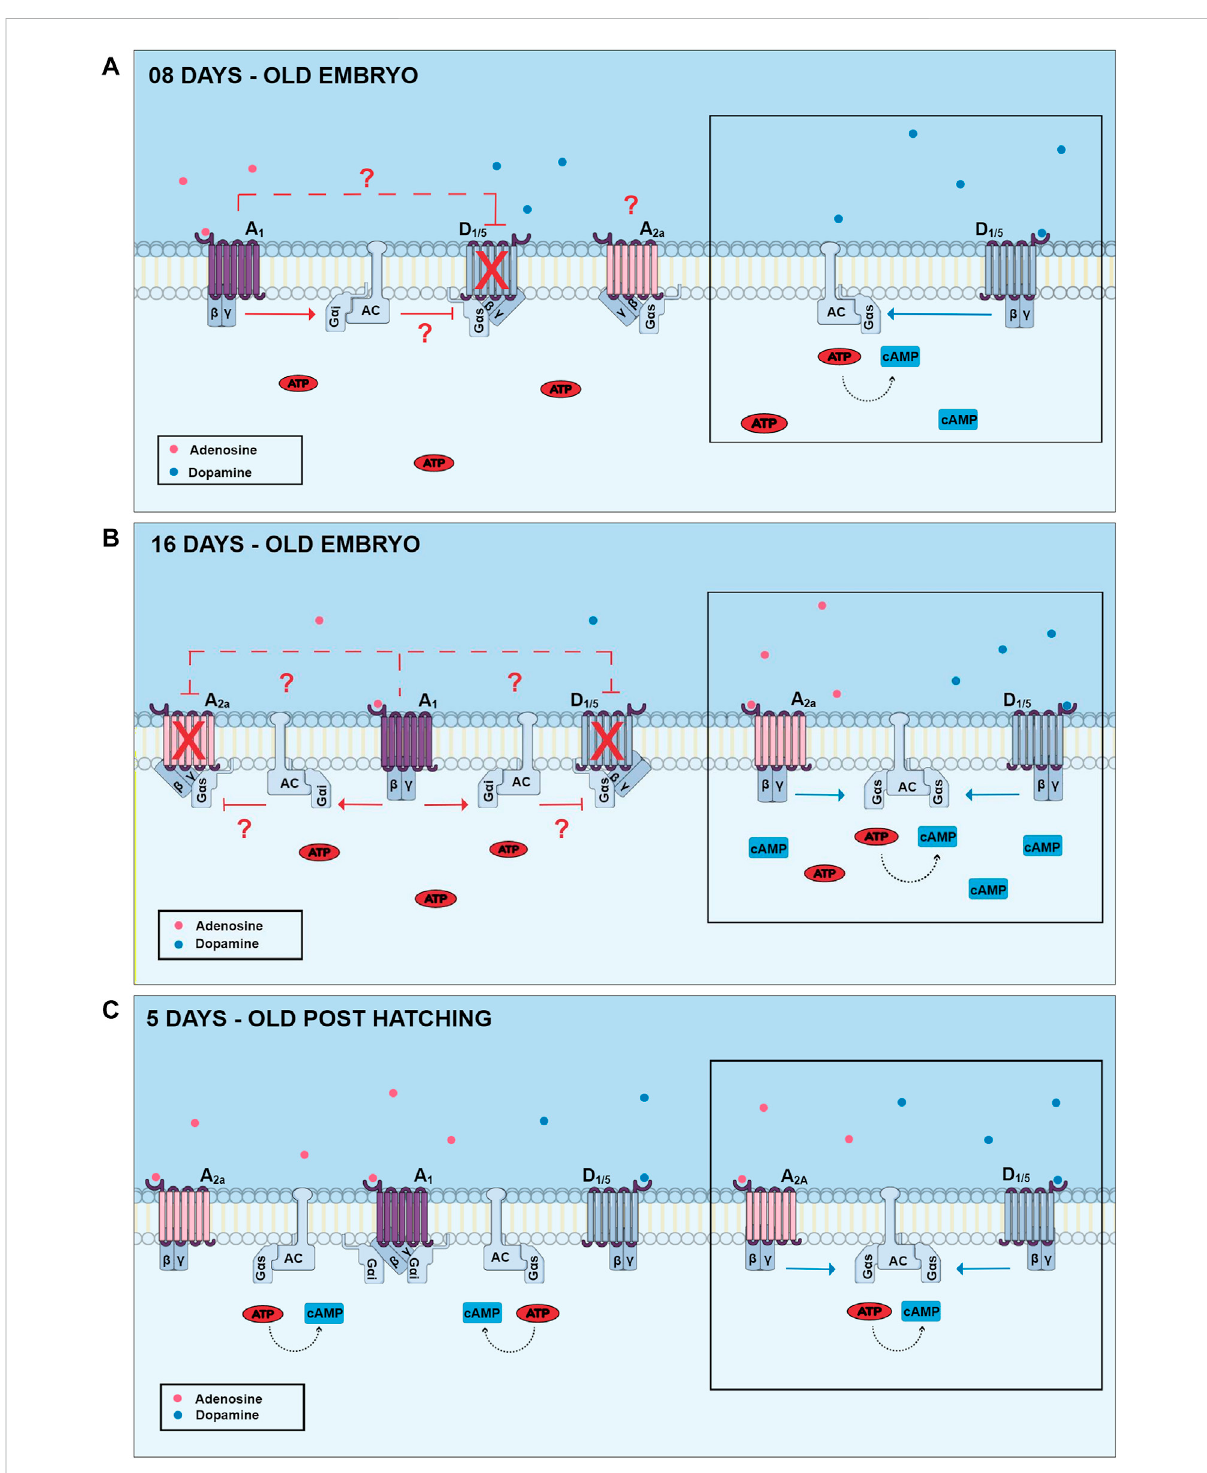
FIGURE 6 Changes of dopamine and adenosine-dependent cAMP levels in three different developmental stages of the chick retina. In E8 retinas, dopamine promotes a high increase of cAMP via stimulation of D1-like receptors (lateral picture), and this effect can be inhibited by activation of adenosine A1receptors. Adenosine A2a receptors are present inthisperiodbut arenot coupled tocAMP production.InE16 retinas, bothD1 andA2a receptorsarepresentandpromotecAMPaccumulation.However,cAMPincreaseisnotadditiveduetothepresenceofA1inhibitoryreceptors. In post-hatching retinas, dopamine and adenosine promote a lower increase of cAMP accumulation and A1 receptor-mediated decrease of dopamine-dependent cAMP accumulation is no longer observed. G α i and G α s are respectively inhibitory and stimulatory G α protein subunits; AC, adenylyl